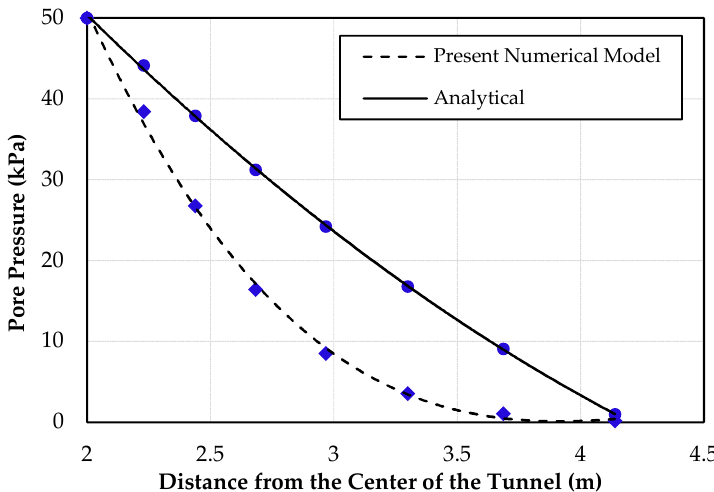
Figure 6. Numerical vs. analytical results for pore pressures in the rock.